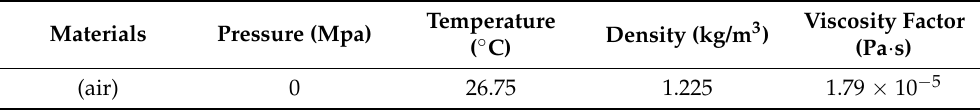
Table 2. Simulated air physical properties parameters [44].